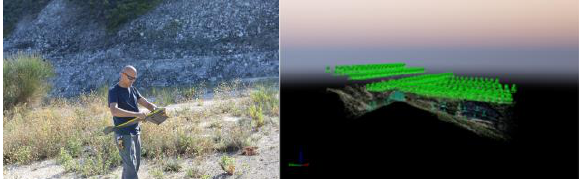
Figure 6. The eleven vertices of the topographic network superimposed to the orthophoto generated from low altitude drone flights.